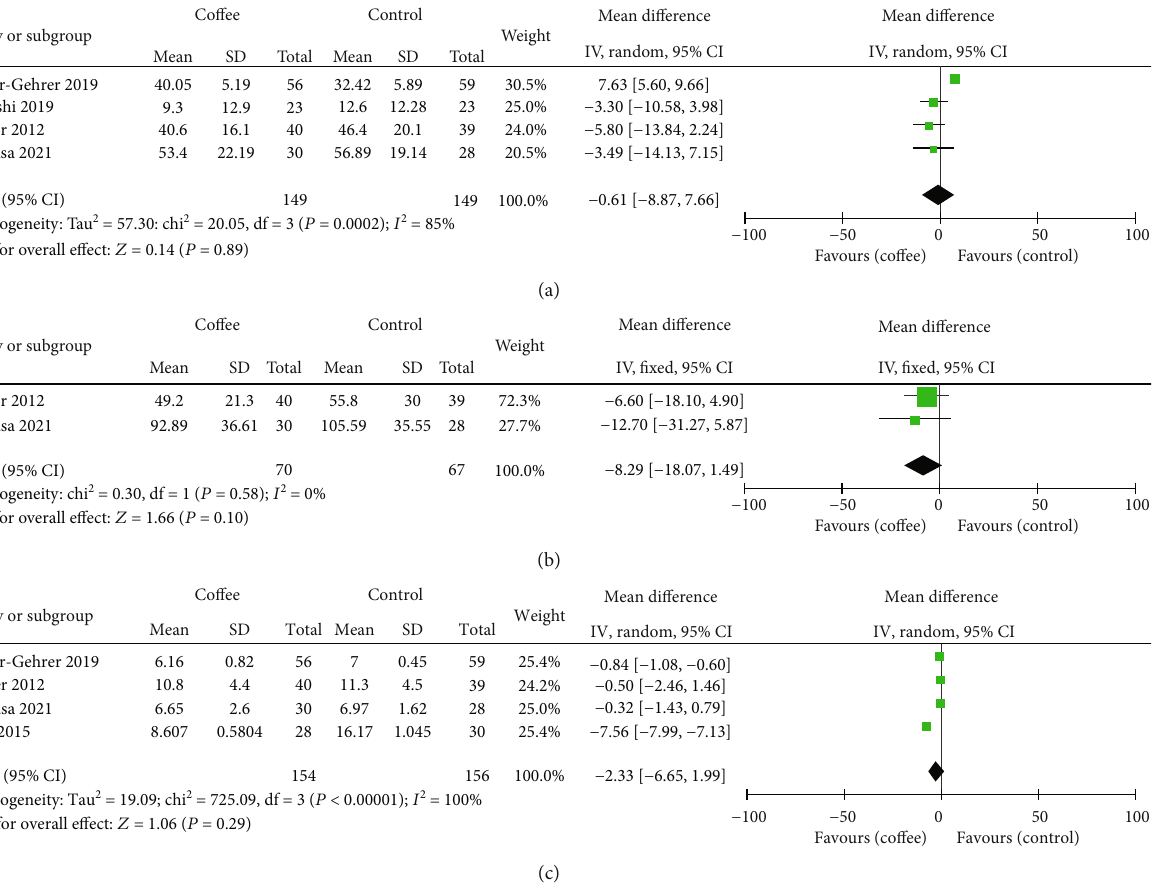
Figure 4: Forrest plot of (a) time to fi rst fl atus, (b) time to tolerance of solid food, and (c) length of hospital stay. Table 2: Meta-analysis of dichotomous secondary